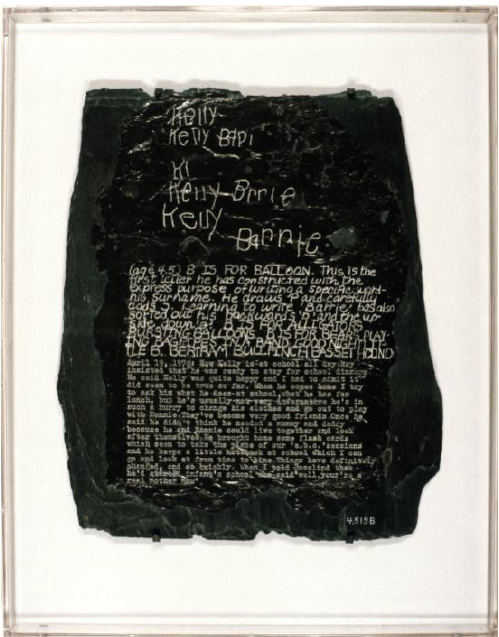
Figure 8: Mary Kelly Post-Partum Document, Documentation VI, Pre- writing Alphabet, Exergue and Diary, 1978, (detail, 1 of 15